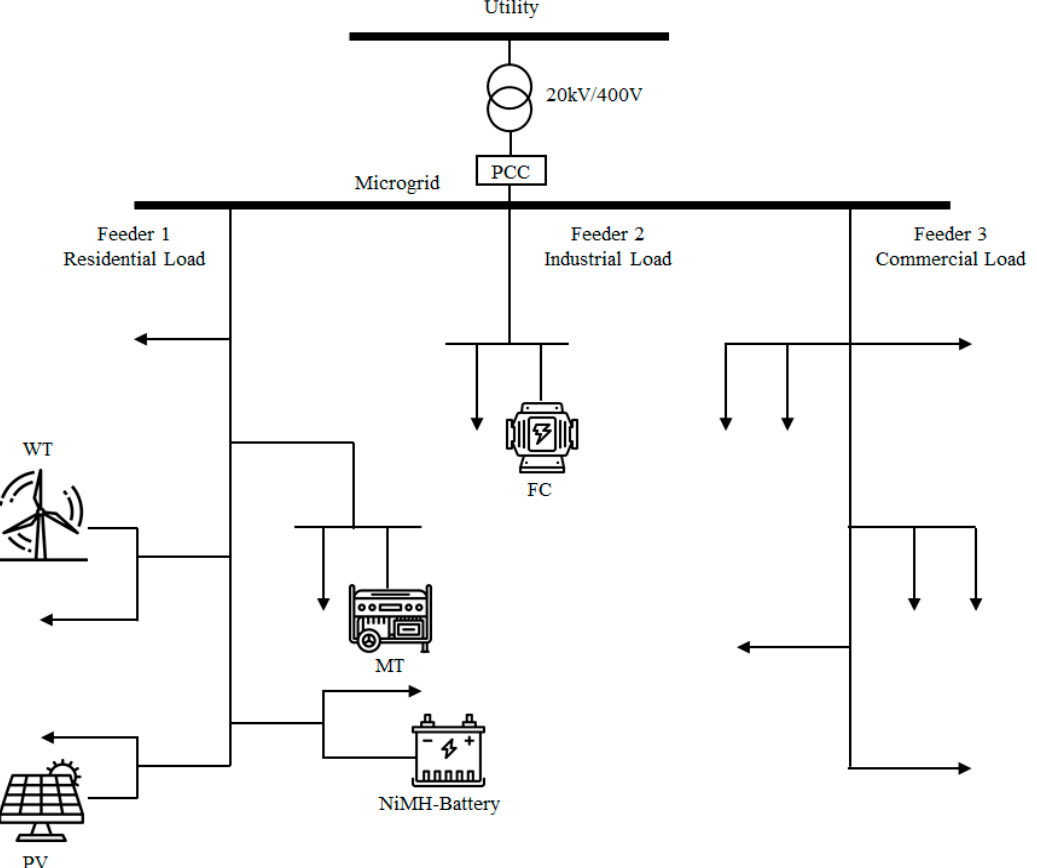
Figure 4. Diagram of a low-voltage grid-connected microgrid (MG). Table 1. Limits and bids of installed distributed generator sources.